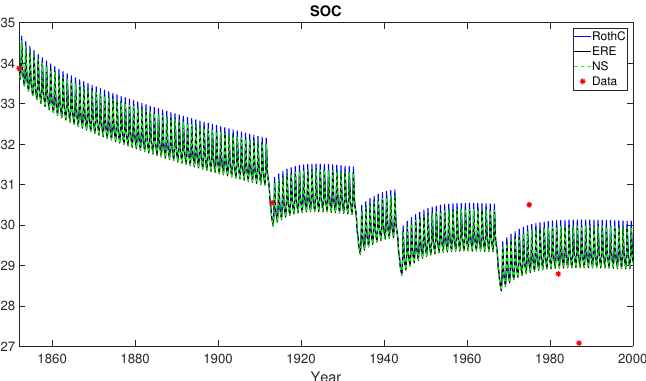
Figure 9. Hoosfield barley experiment. Scenario 1: unmanured treatment. Organic C in soil data (red bullets) modelled by the RothC (8), ERE (13) and NS (17) methods in the temporal horizon [ 1852, 2000 ] with ∆ t = 1. According to Table 3, ERE approximation shows the best performance with respects to both the statistical indicators RMSE and modelling Efficiency